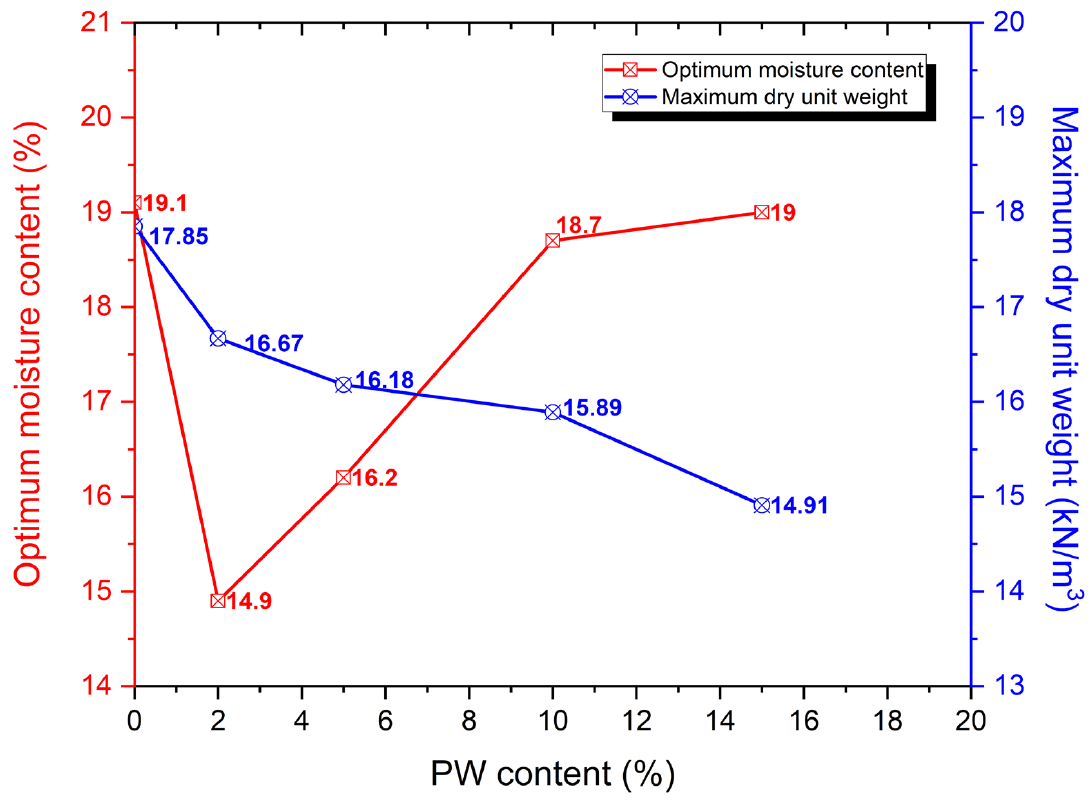
Figure 5. Variation of compaction characteristics for cement-stabilised soil with PW content .